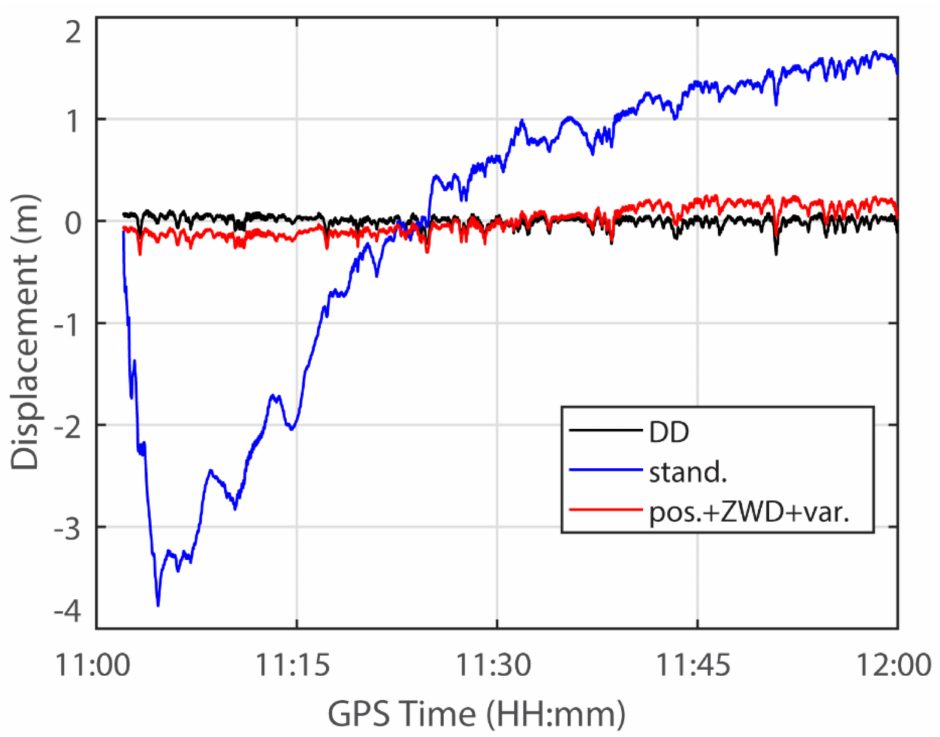
Figure 10. Comparison of position-constrained PPP and DD displacement time series after the data gap at point B.